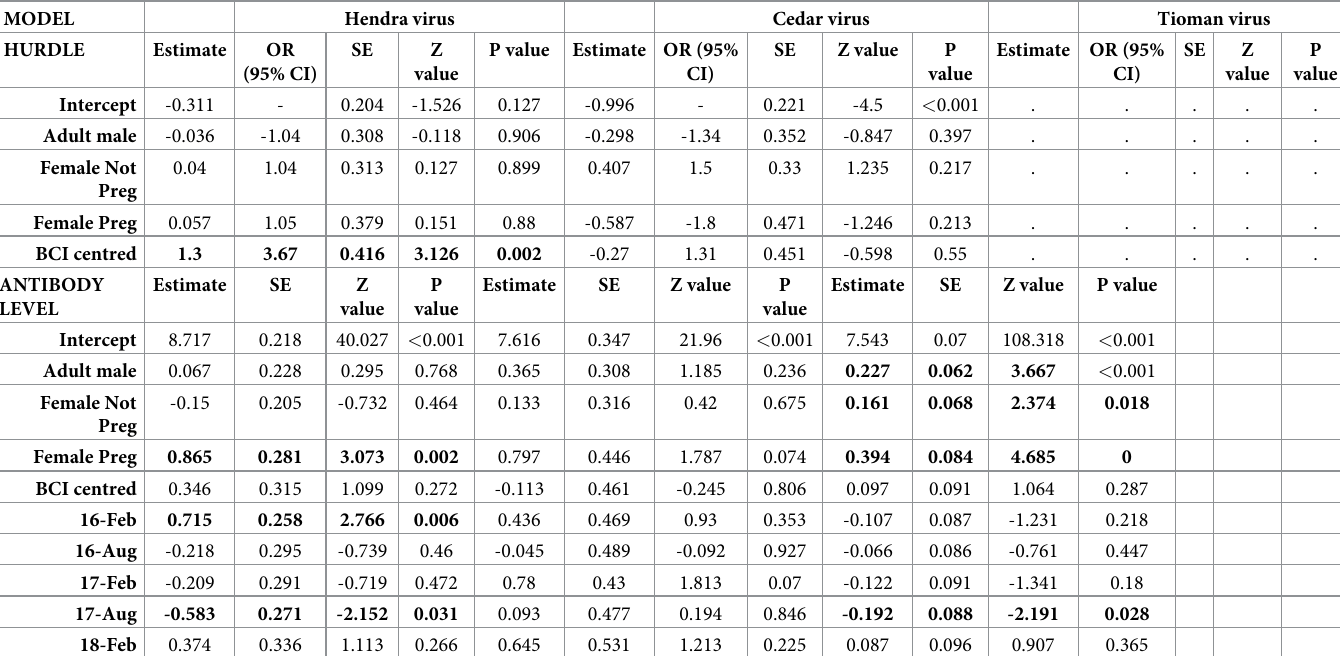
Table 4. Statistics for hurdle and antibody level models. MODEL Hendra virus Cedar